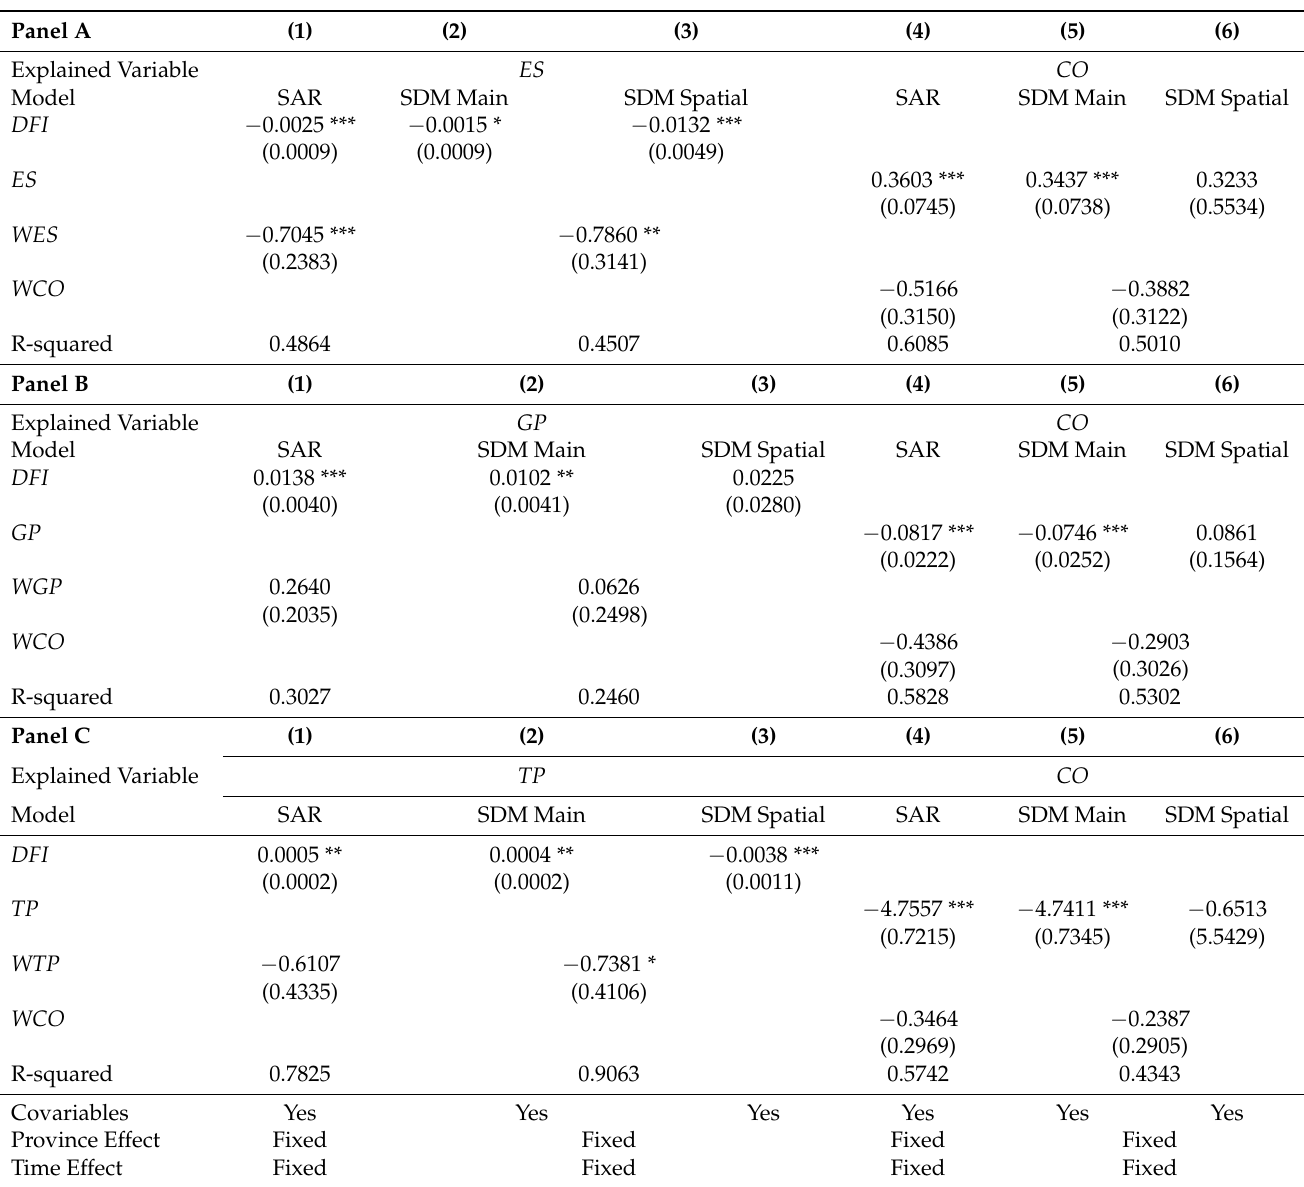
Table 7. Mediating mechanisms